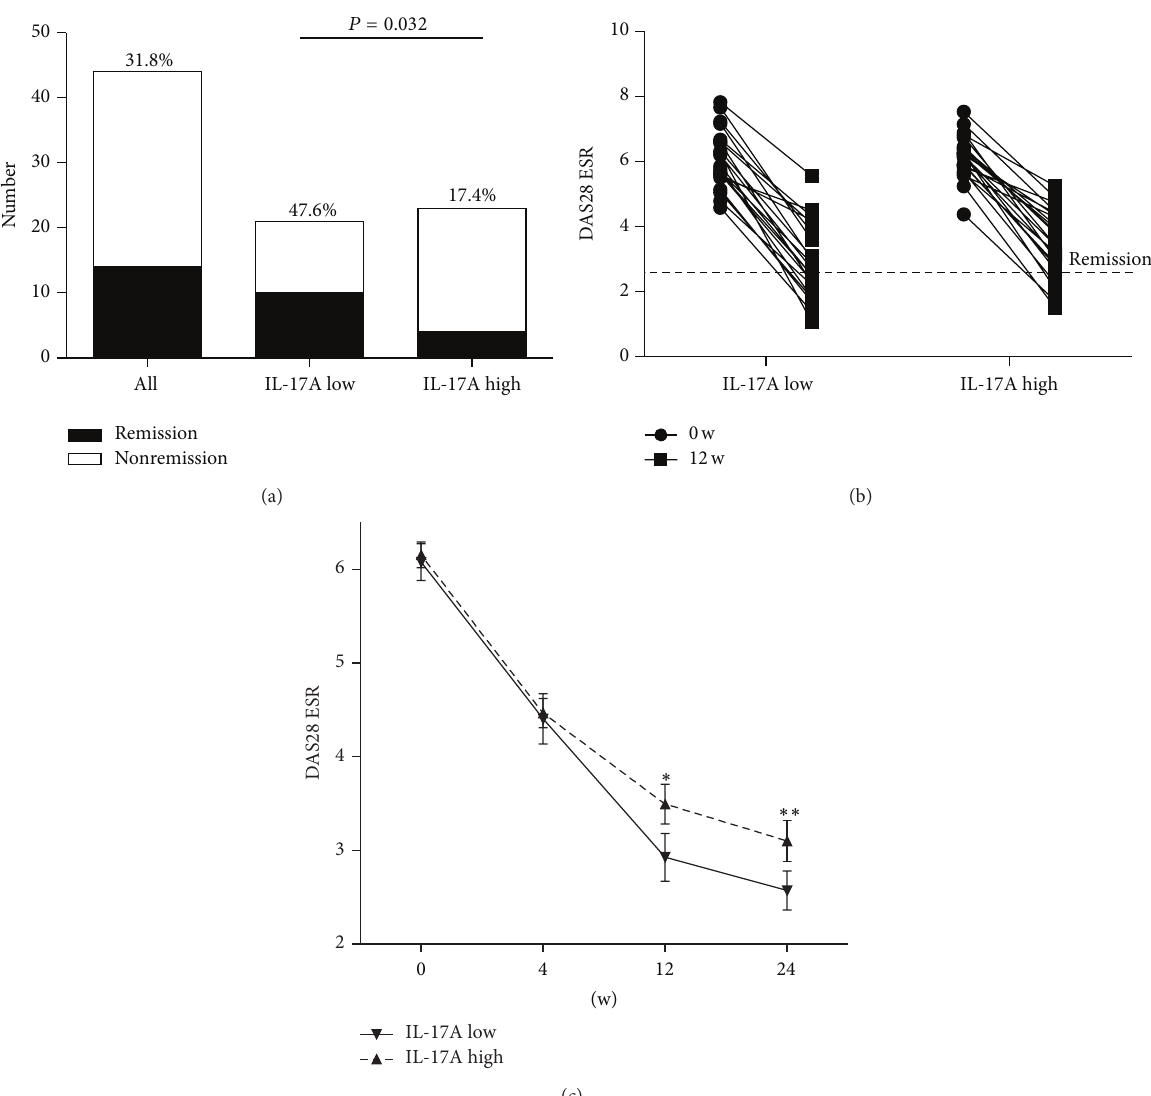
Figure 3: Low baseline levels of IL-17A are associated with DAS28 ESR remission at 12 weeks of tocilizumab treatment. A significantly higher proportion of patients in the IL-17A low group achieved DAS28 remission at 12 weeks as compared to the IL-17A high group (47.6 versus 17.4%, 𝑃 = 0.032 ) by Fisher’s exact test (a). Individual DAS28 ESR improved in both groups. However, the improvement in DAS28 ESR was more profound in the IL-17A low group with higher remission rate (b). The improvement in DAS28 ESR was better in the IL-17A low group at 12 weeks ( ∗ 𝑃 = 0.045 ) and 24 weeks ( ∗∗ 𝑃 = 0.046 ) after tocilizumab treatment after adjusting for baseline DAS28 ESR, RF positivity, and levels of TNF- 𝛼 , IL-21, and IL-23. Data represents mean value ± SEM